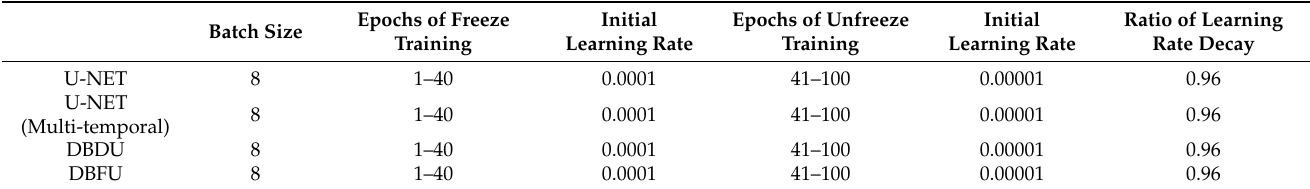
Table 1. Model hyperparameters for four